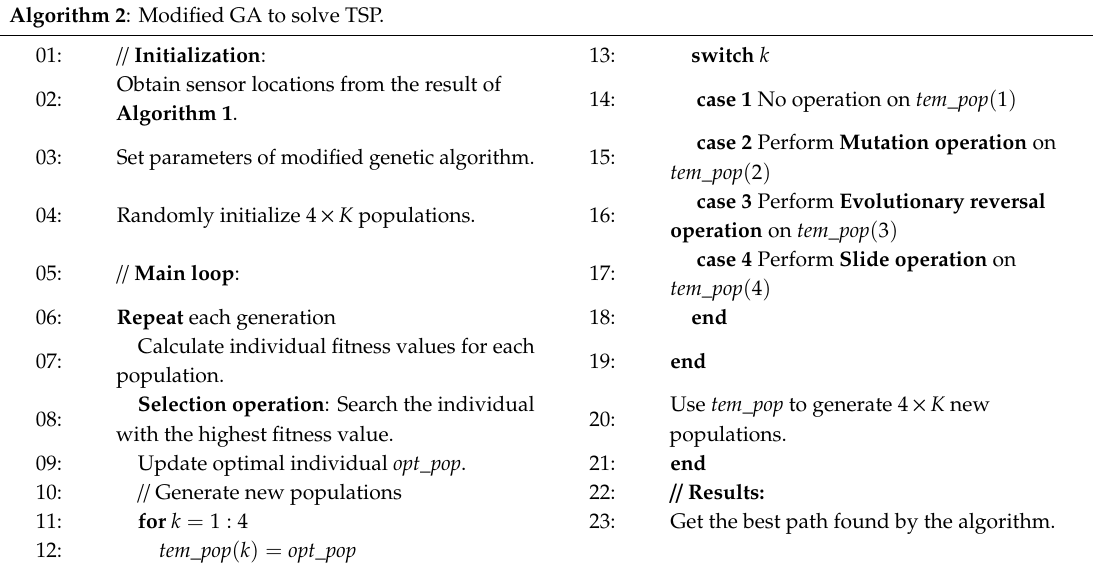
Algorithm 2. Pseudo-code of modified genetic algorithm (GA) to solve the travelling salesman problem (TSP). Algorithm 2 : Modified GA to solve